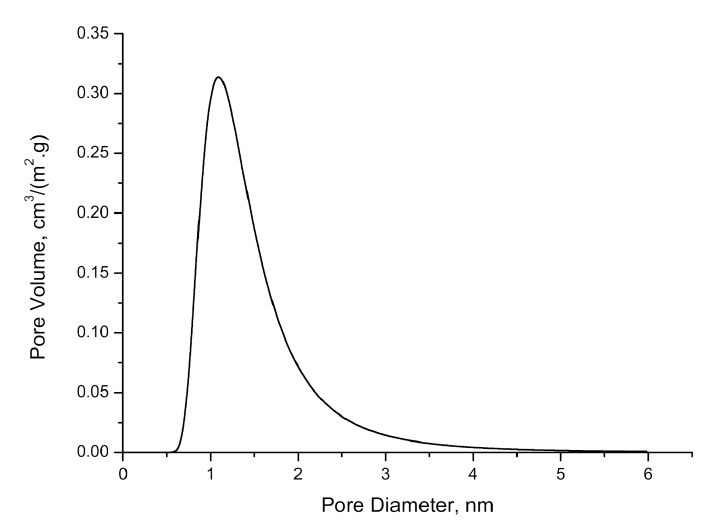
Figure 2. Micropore size distribution